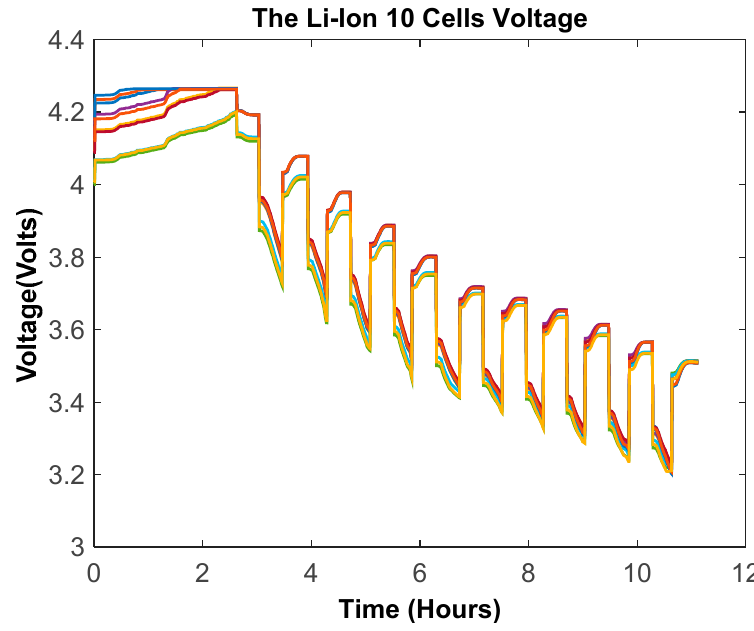
Figure 10. The voltages of the 10 cell pack.